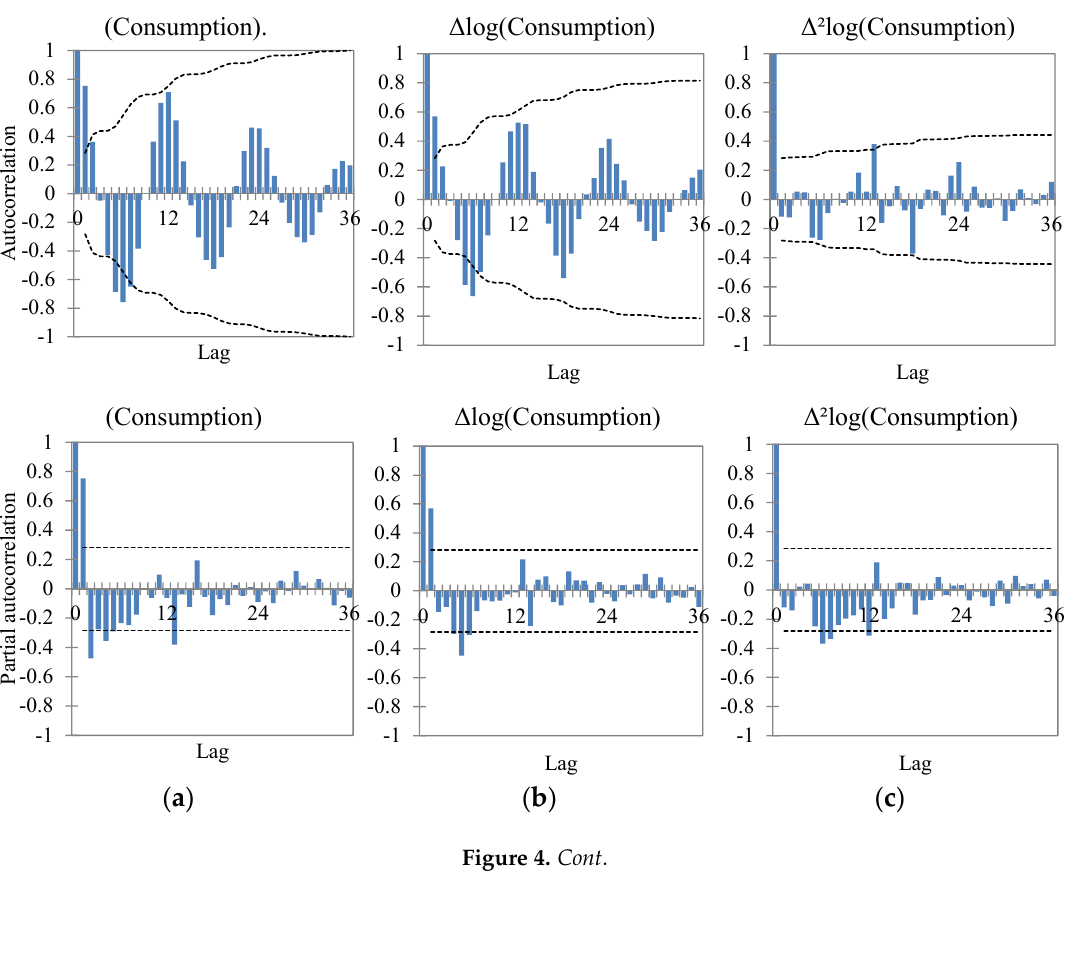
10 of 17 Table 4. Stationary test for consumption series. p ‐ Value for Stationary